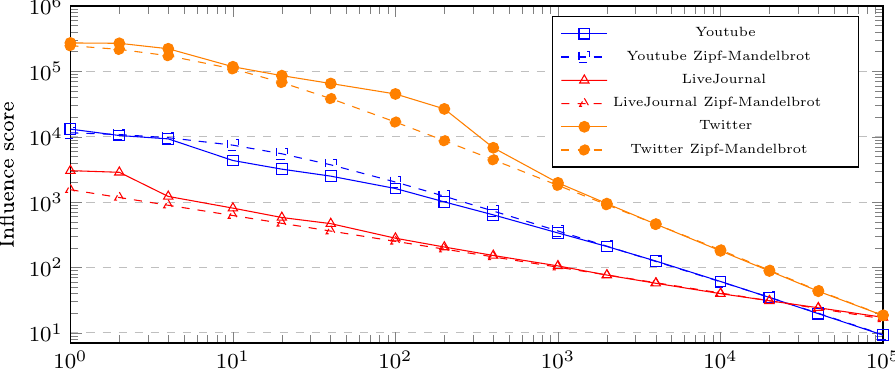
Fig. 3 Datasets’ influence score